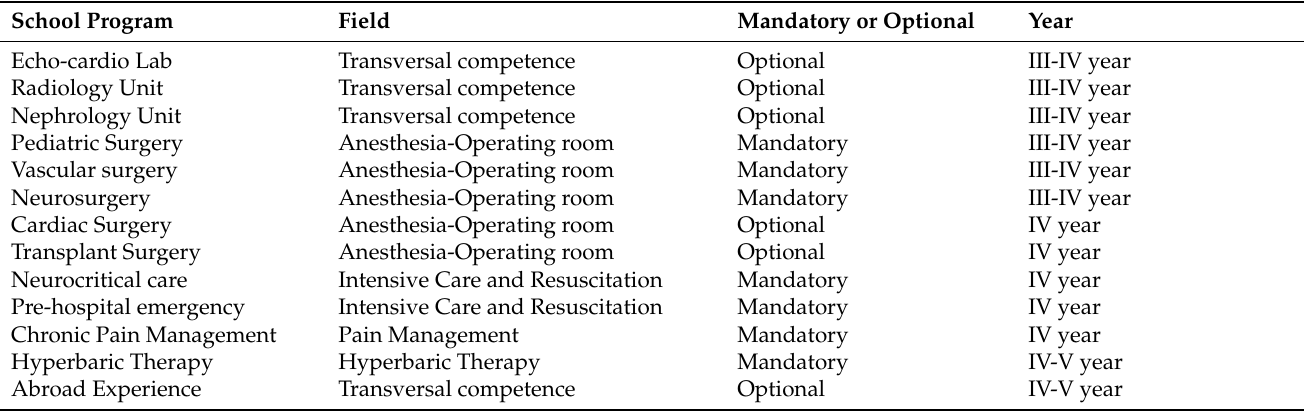
Table A4. Program of school of Anesthesia and Intensive Care of University of Modena and Reg- gio